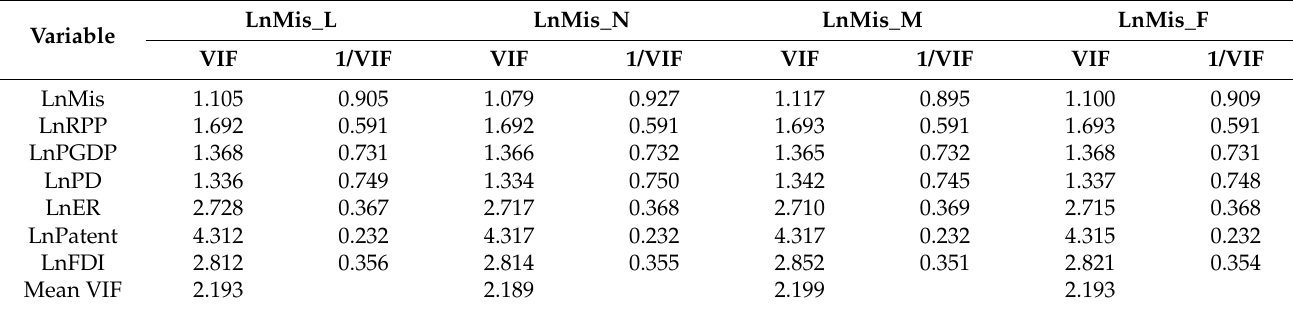
Table 3. Multicollinearity test results.